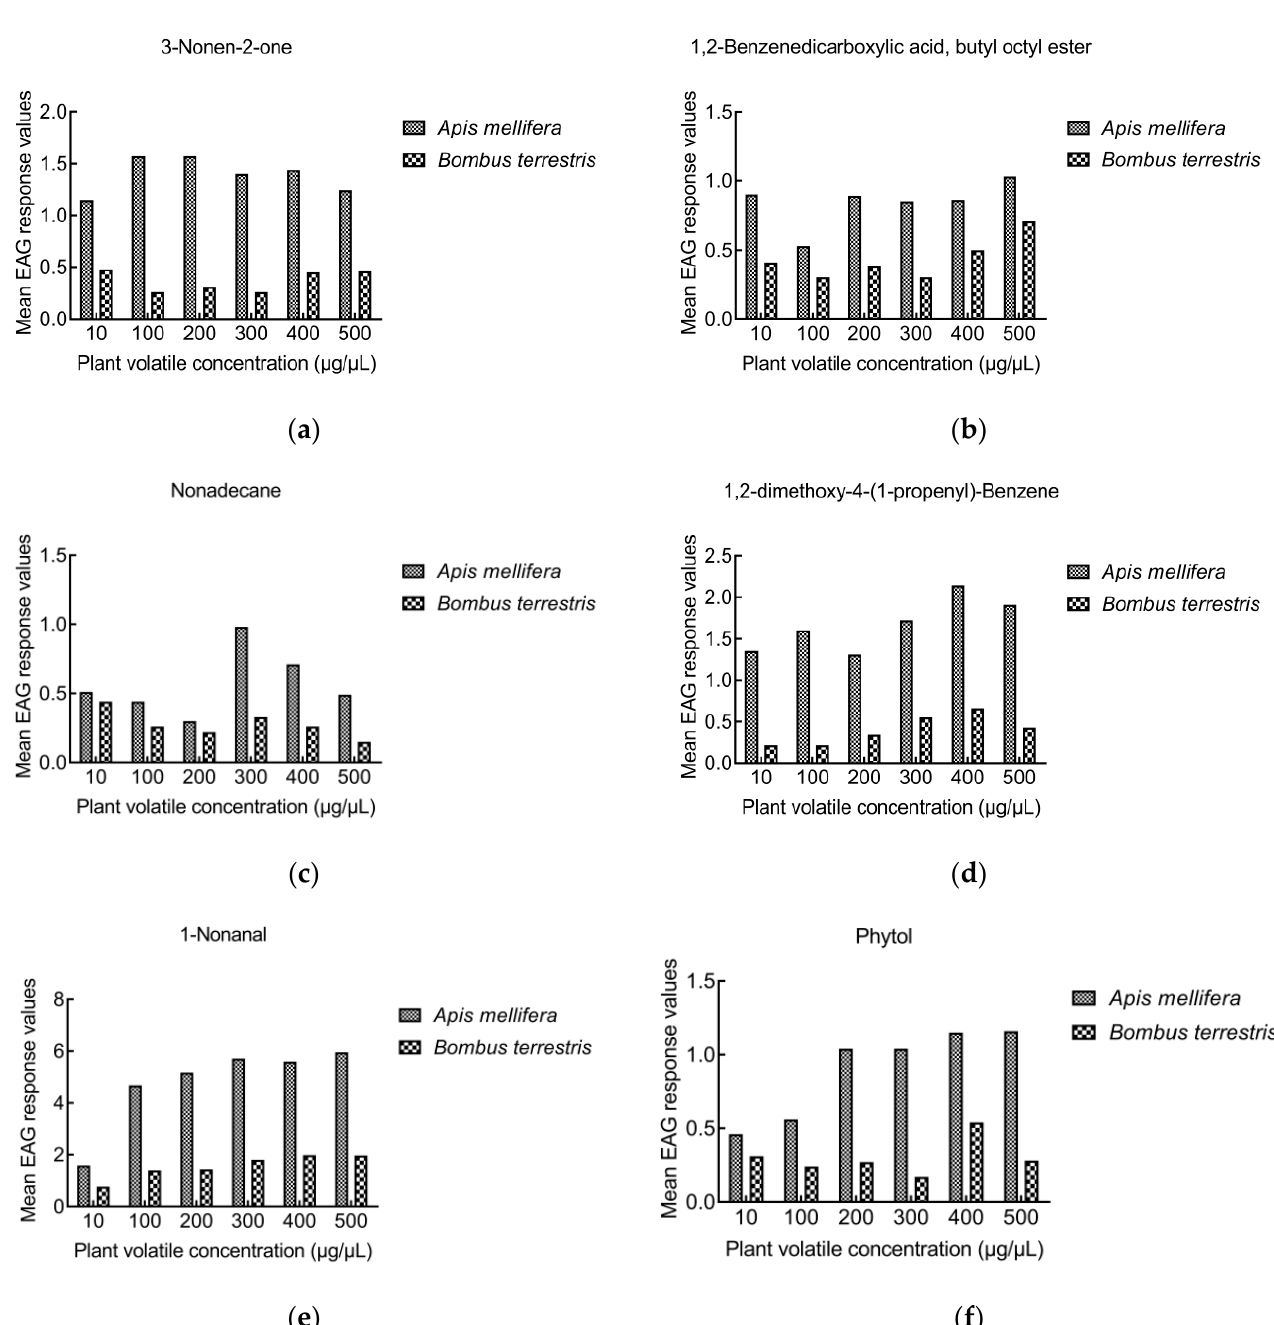
Figure 3. Comparison of EAG responses between A. mellifera and B. terrestris . The rEAGs of A. mellifera are higher than those of B. terrestris : ( a ) 3-nonen-2-one, ( b ) 1,2-benzene dicarboxylic acid, butyl octyl ester, ( c ) nonadecane, ( d ) 1,2-dimethoxy-4-(1-propenyl)-benzene, ( e ) 1-nonanal, ( f ) phytol.